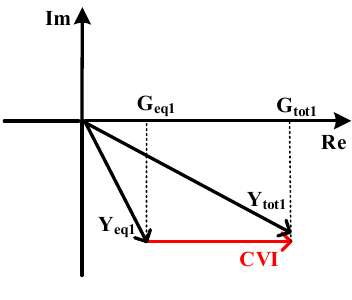
Figure 12. Definition of CVI.